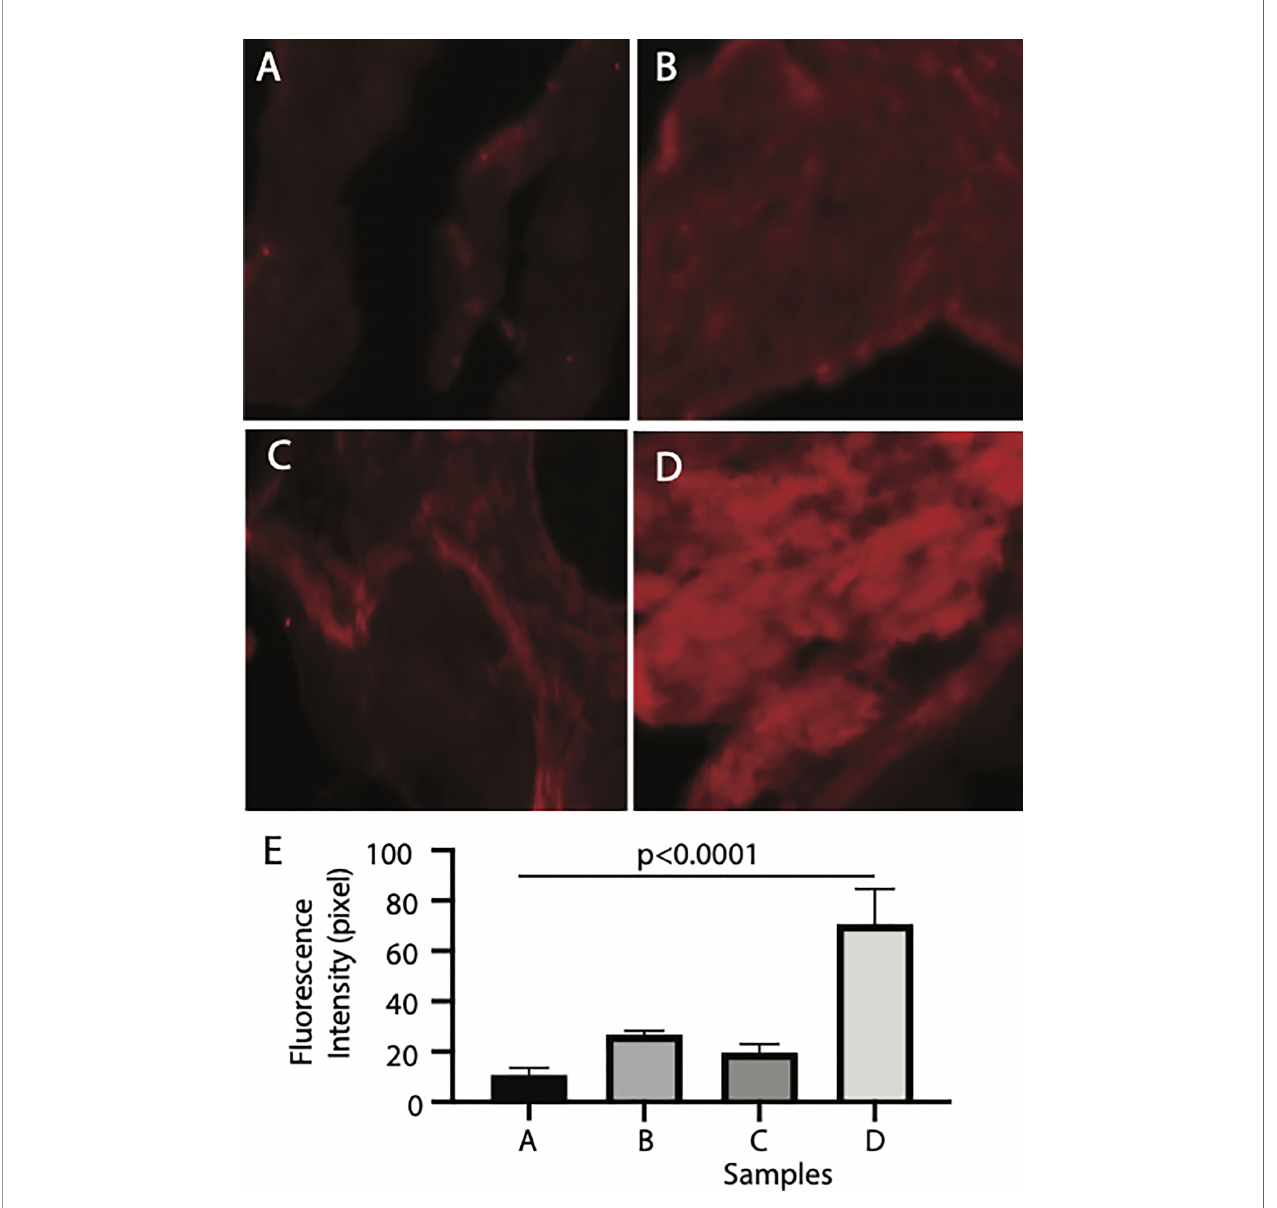
FIGURE 6 | Recombinant Pfs16 protein bound to blood-fed mosquito midguts. (A) The naïve mosquito midguts were incubated with unrelated protein (CAT). (B) The blood-fed mosquito midguts incubated with un-related protein (CAT). (C) The naïve mosquito midguts incubated with Pfs16. (D) The blood-fed mosquito midguts incubated with Pfs16 protein. (E) The median fl uorescence intensity of differently treated midguts. P. Calculated with one-way